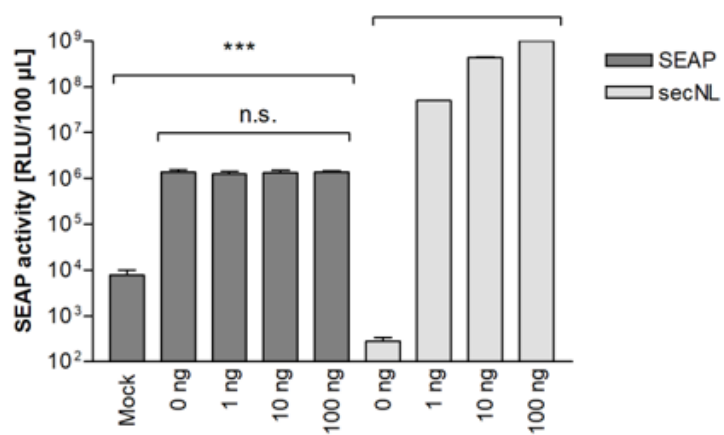
Figure 6. Co-expression of secNLuc as dual reporter sys tem in SRFIA has no effect on SEAP levels. The effect of co-transfection of reporter cells with secNLuc on SEAP levels is shown. Reporter cells cultivated in 24-well plates were co-transfected with HSV-1 glycoproteins (500 ng gB-1, 660 ng gD-1, gH-1, and gL-1 each) and varying amounts of plasmid pEN-secNL as indicated, mock: empty gB-1 vector backbone. 48 h after transfection, secNLuc and SEAP levels were quantified in culture supernatants. Mock: empty gB-1 vector backbone. Data represent means ± SD from quadruplicate, n.s. not significant, p < 0.001 (***).